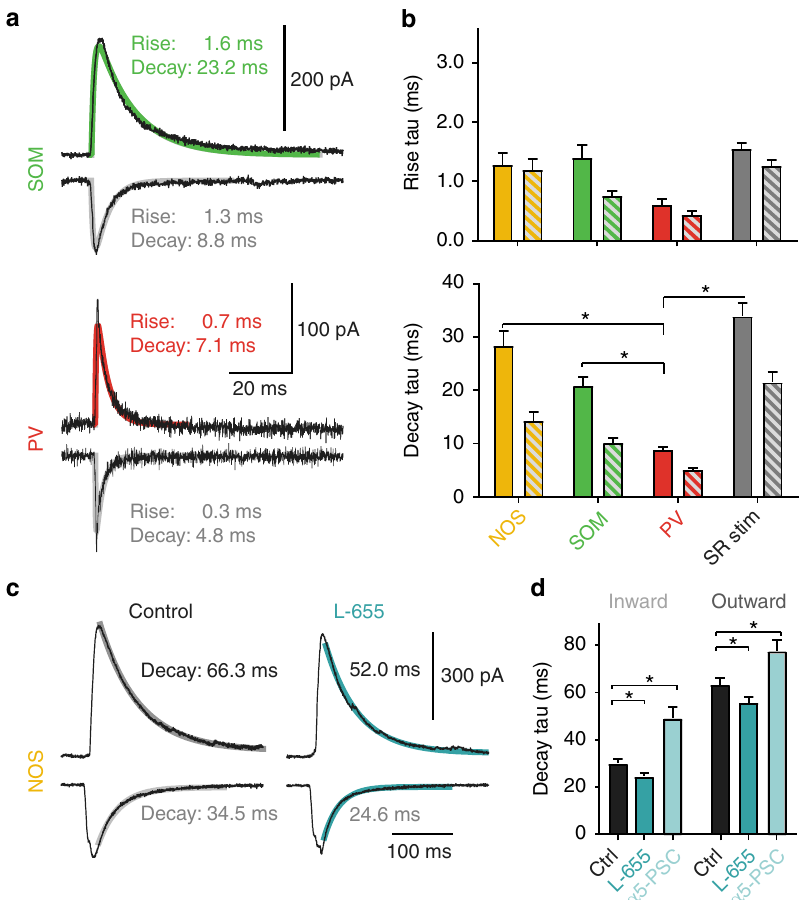
Fig. 5 Slow PSC kinetics of dendritic GABAergic inputs. a Representative mean IPSCs generated by optogenetically activated inputs from SOM (top) and PV interneurons (bottom). The internal Cs-gluconate-based solution had a realistically low chloride concentration of 8 mM. Outward currents were measured at – 10 mV, inward currents at – 82 mV. Biexponential fi ts to rising and falling phases of IPSCs are indicated. b Group means of rise and decay τ . Outward currents are indicated by solid colors, inward currents by striped bars. Note the slower rise and decay τ for all dendritric inputs compared to PV- ChR2-evoked perisynaptic IPSCs. The signi fi cant differences in outward decay τ are indicated (all: P < 0.001; two- sample t test, NOS: n = 9; SOM: n = 9; PV: n = 8; SR stim: n = 11). c Representative mean IPSCs optogentically activated from NOS interneurons before and after application of the α 5-IA L- 655,708 (L-655, 50 nM). Outward currents were measured at – 10 mV, inward currents at – 90 mV. Monoexponential fi ts to the decay phase of IPSCs are indicated. Note the faster decays after application of L-655,708. d Group means of decay τ for NOS-ChR2- evoked IPSC before and after L-655,708 and the α 5-GABAR-mediated difference current. Decay τ signi fi cantly sped up after application of L-655,708 for both inward ( P < 0.001; paired t test, n = 10) and outward currents ( P < 0.001). Control decay τ was also signi fi cantly faster than for the α 5-GABAR-mediated difference current (both: P < 0.05, n = 7). Recording temperature T ≈ 33 °C for a , b and T ≈ 22 °C for c ,